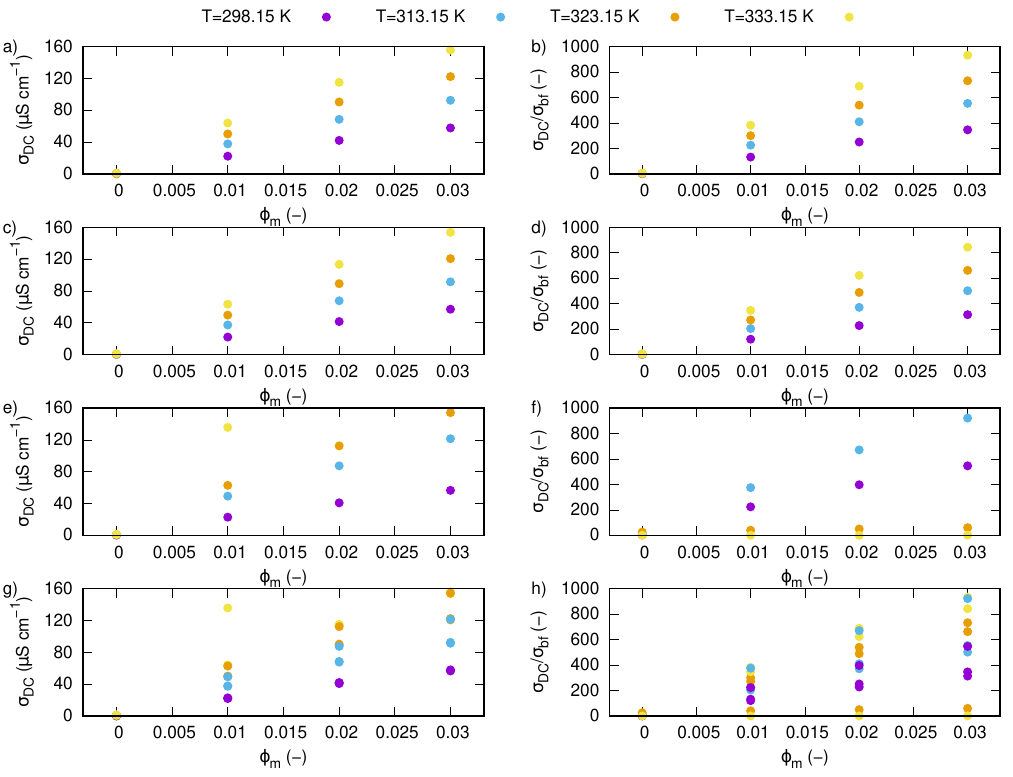
Figure 11. Values of DC electrical conductivity vs. mass fraction for various temperatures for silicon oxide lignin nanofluids ( a ) calculated based on Nyquist plots (Figure 9 and Equation (2)), and ( b ) their enhancement, ( c ) calculated based on AC conductivity (Figure 13) and ( d ) their enhancement, ( e ) directly measured by DC conductivity probe and ( f ) their enhancement, ( g ) comparison of results obtained with different methods and ( h ) their